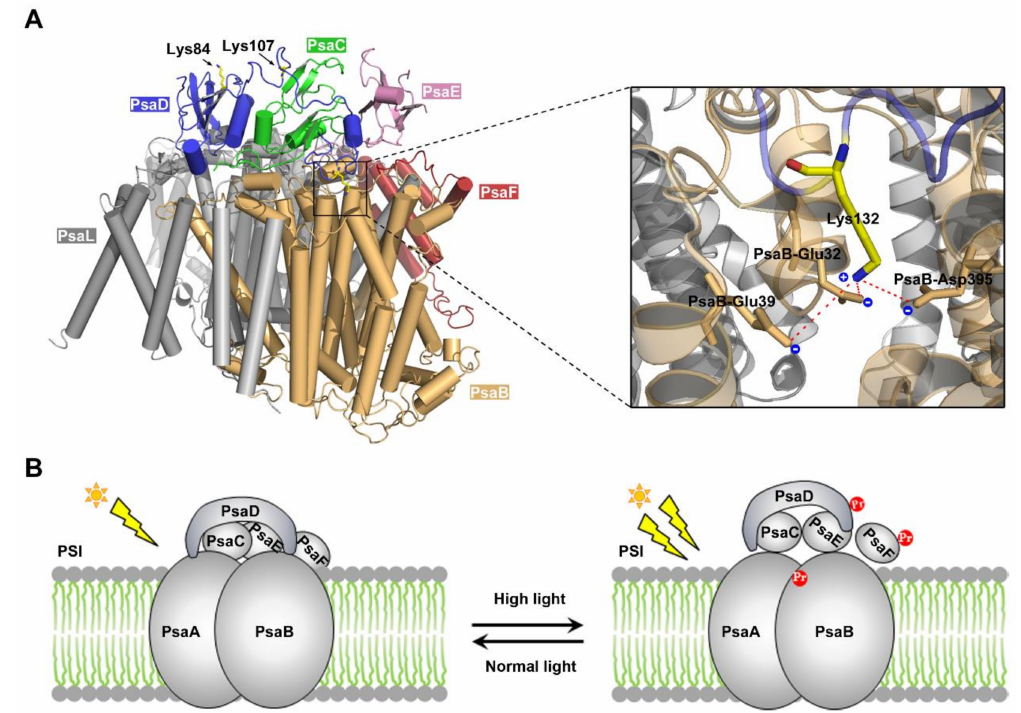
Figure 7. Analysis of the functional roles of PsaD propionylation. ( A ) The crystal structure of PsaD and other PSI subunits. The interactions between Lys132 side chain and the negatively charged amino acids are shown in detail. Lysine amine nitrogen of PsaD is within 5 Å of the Glu32, Gly39, and Glu395 of PsaB. ( B ) Schematic summary of the proposed model of the role of PsaD propionylation during HL acclimation in Synechocystis . The Pr highlighted in red represents